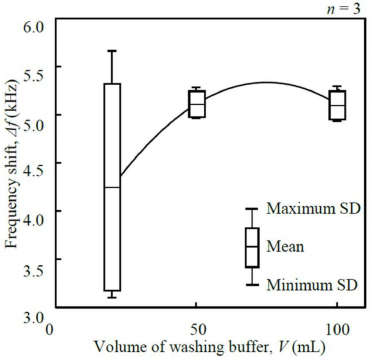
Figure 9. Relationship between the frequency shift, ∆ f , and the volume of washing buffer, V (1.402 MHz measured